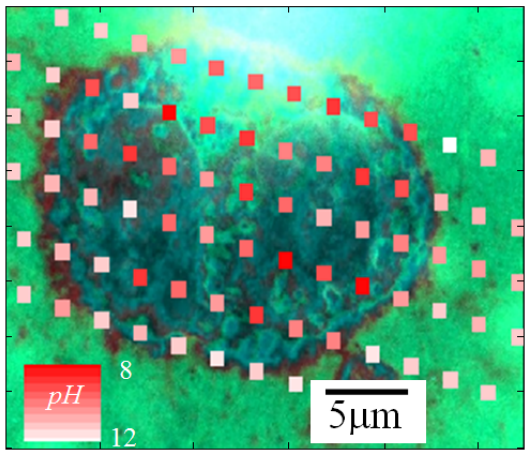
Figure 7. pH evaluation of a single fixed cell by the Raman response of the graphene. The cell area has been scanned at the micrometric scale. Color scale range between pH = 8 (red) and 12